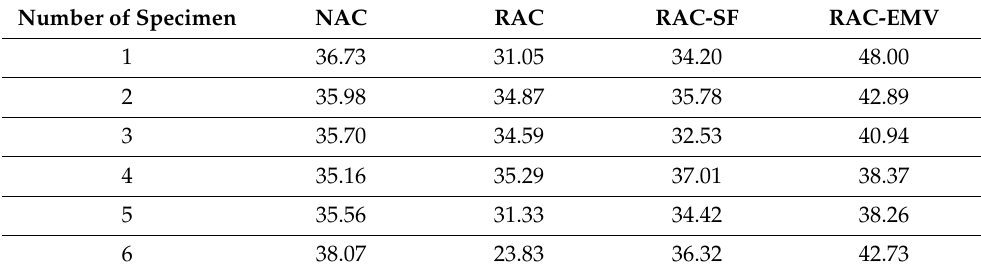
Table 5. Compression test results of